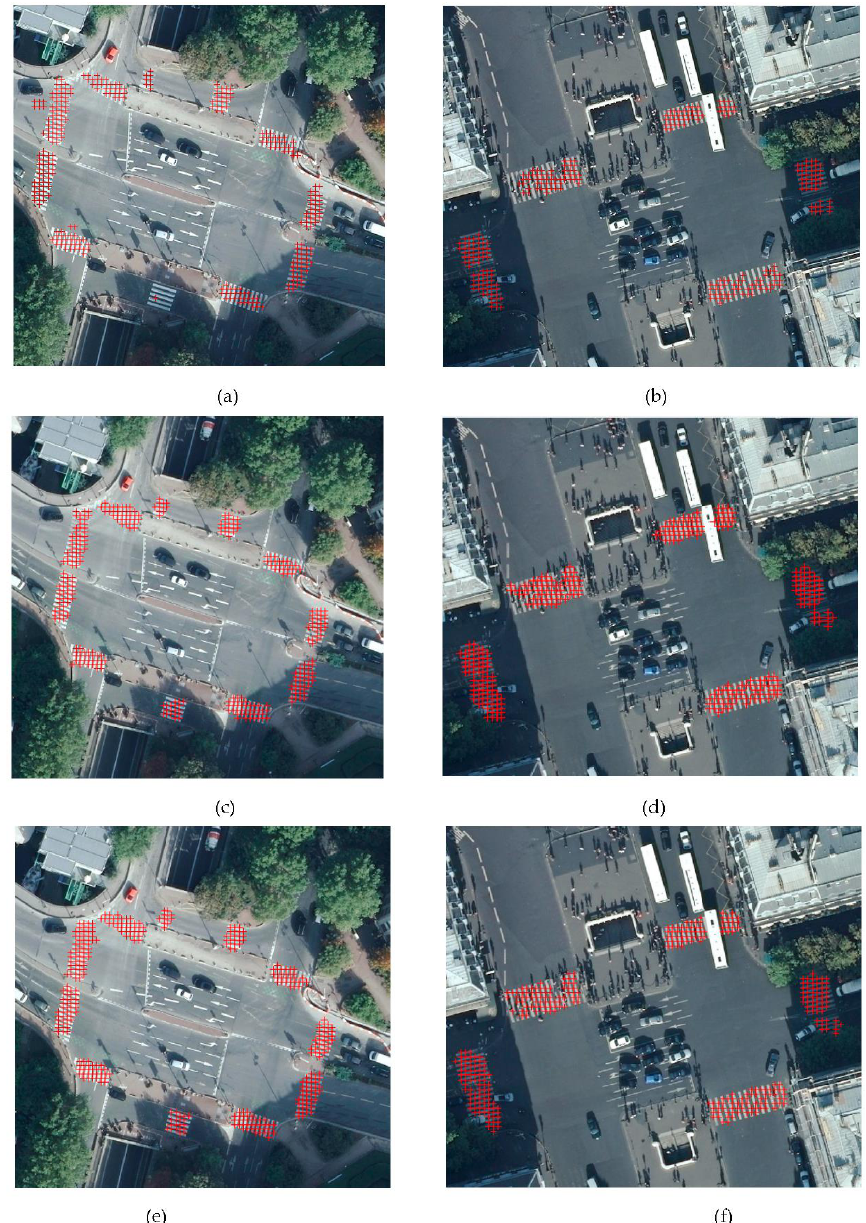
Figure 16. ( a , b ) are the results under condition 1; ( c , d ) are the results under condition 2; ( e , f ) are the results under condition 3.